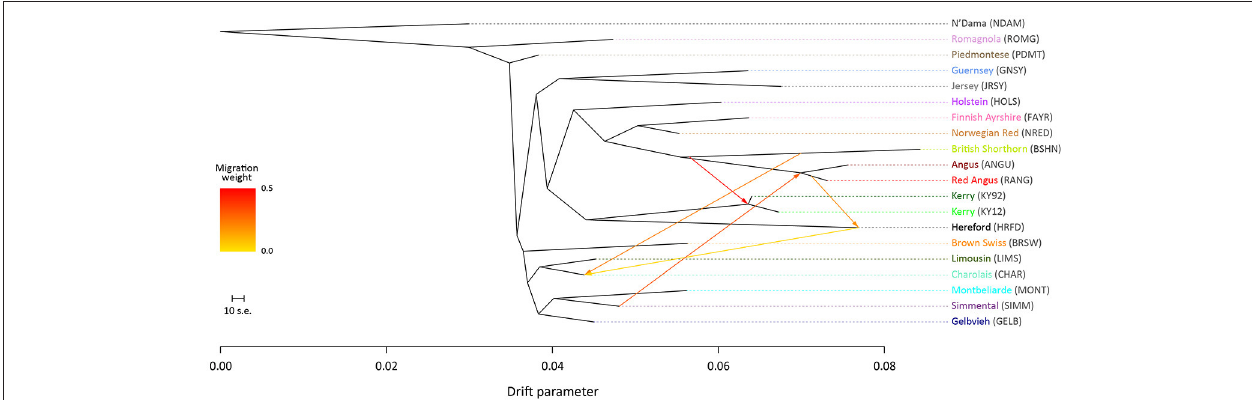
FIGURE 2 | Maximum likelihood (ML) phylogenetic tree network graph with five migration edges ( m = 5) generated for genome-wide SNP data (36,000 autosomal SNPs) from European cattle breeds (EU data set). The West African taurine N’Dama breed sampled in Guinea is included as a population outgroup. Coloured lines and arrows show migration edges that model gene flow between lineages with different migration weights represented by the colour gradient.